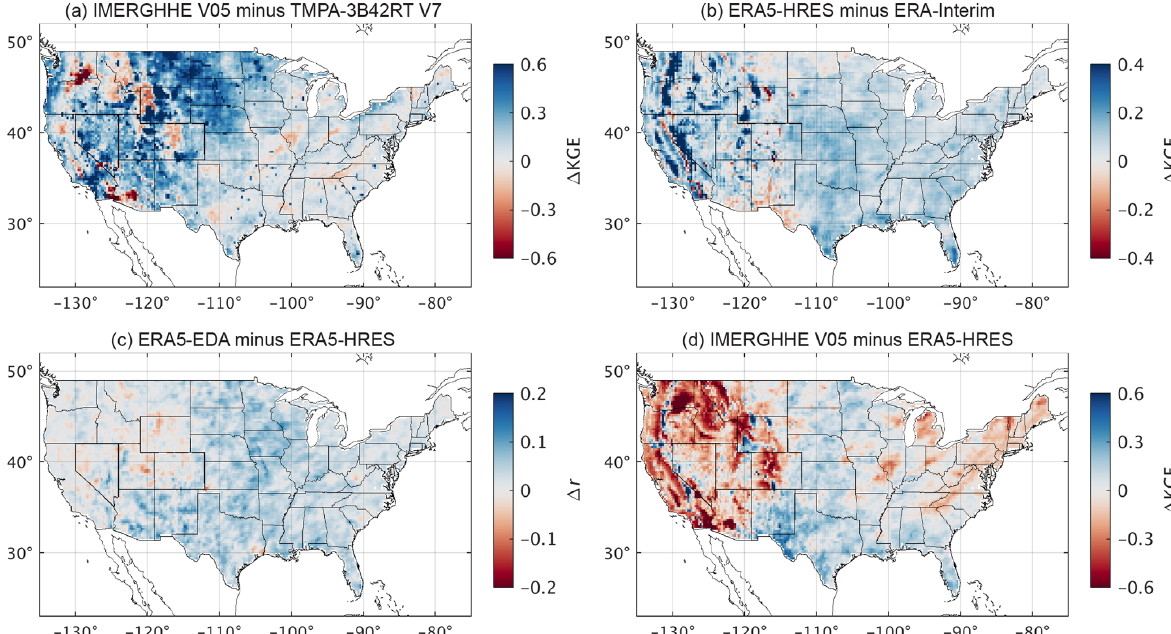
Figure 4. (a) KGE scores obtained by IMERGHHE V05 minus those obtained by TMPA-3B42RT V7. (b) KGE scores obtained by ERA5- HRES minus those obtained by ERA-Interim. (c) Correlations ( r ) obtained by ERA5-EDA minus those obtained by ERA5-HRES. (d) KGE scores obtained by IMERGHHE V05 minus those obtained by ERA5-HRES. Note the different color scales. The Stage-IV gauge-radar dataset was used as a reference. The KGE and correlation values were calculated from daily time